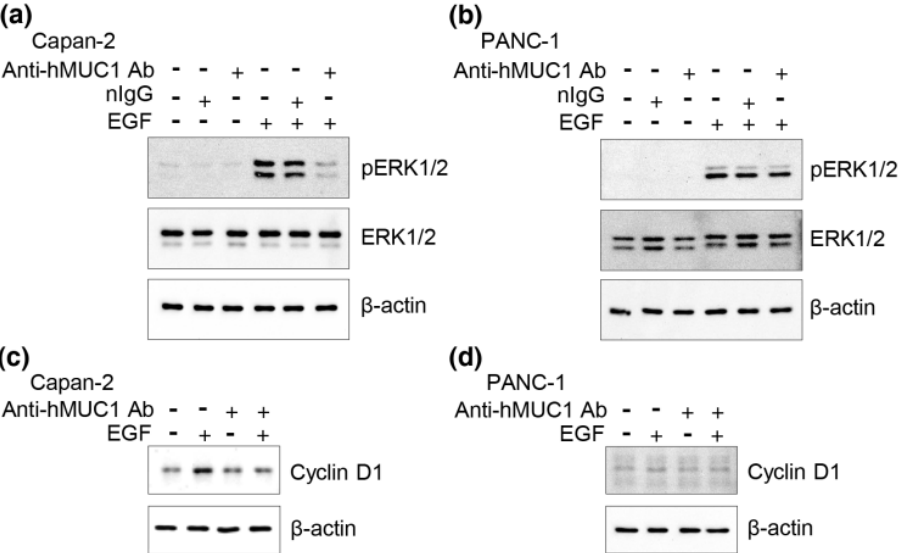
Figure 3. Inhibition of EGF-induced ERK phosphorylation and cyclin D1 expression by anti-hMUC1 monoclonal antibody. ( a ) Capan-2 and ( b ) PANC-1 cells were pretreated with 10 µ g/mL anti-hMUC1 monoclonal antibody (anti-hMUC1 Ab) for 6 h followed by stimulation with 10 ng/mL EGF for 5 min. Cell lysates were separated by SDS-PAGE and western blot analysis was performed with anti-phospho-ERK, anti-ERK and anti- β -actin antibodies. ( c ) Capan-2 cells and ( d ) PANC-1 cells were treated with 10 µ g/mL anti-hMUC1 monoclonal antibody for 6 h followed by treatment with 10 ng/mL EGF and incubated for 24 h. Cell lysates were separated by SDS-PAGE and western blot analysis was performed with anti-cyclin D1 and anti- β -actin antibodies. These results are representatives of three independent experiments.